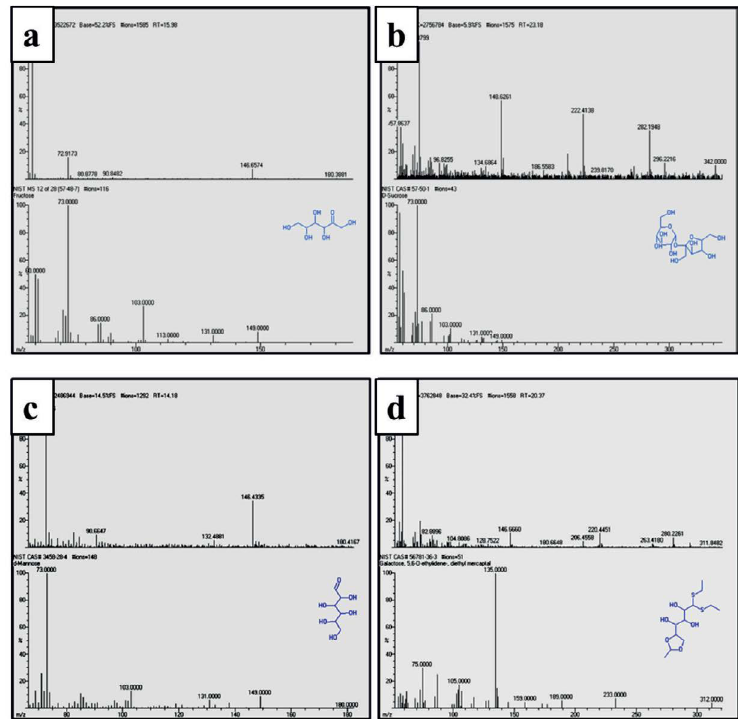
Fig. 4. GC/MS chromatogram of monomeric sugar units identified in the bioflocculant a) D-Fructose, b) D-Sucrose, c) D-Mannose, d)